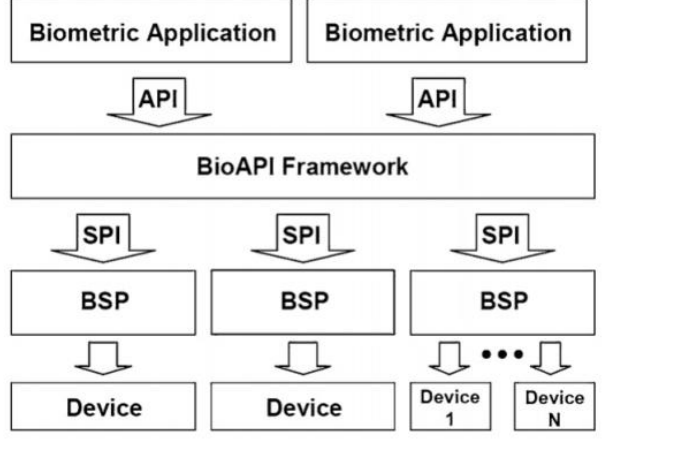
Figure 1 – BioAPI’s API/SPI model (Thevenot et al, 2001) Рис. 1 – BioAPI API/SPI модель (Thevenot et al,